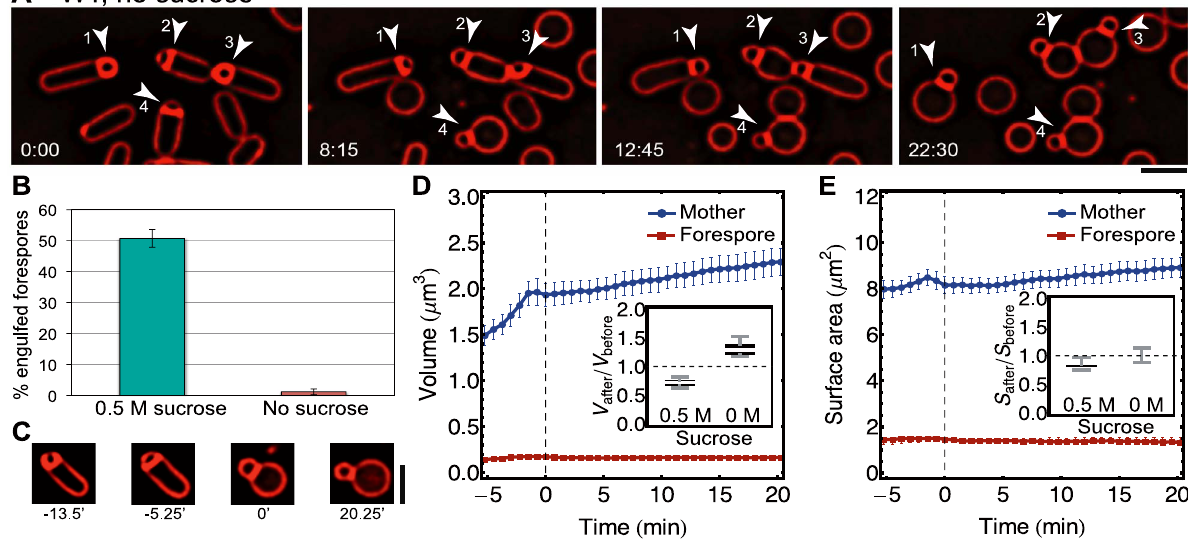
Figure 7. Decreasing medium osmolarity causes retraction as theoretically predicted. (A) Medial focal plane images of sporulating cells treated with lysozyme in osmotically protected medium but without sucrose (see Materials and Methods, Movie S4). Fully engulfed cells retract (cells 1 and 3) while partially engulfed cells (cells 2 and 4) fail to engulf and undergo retraction as well. (B) Percentage of forespore engulfment after lysozyme treatment in medium with 0.5 M sucrose and without sucrose. Average + / 2 STD of four different microscopy fields, each containing 136– 160 cells in sucrose condition and 93–173 cells without sucrose. (C) Images of typical cell undergoing swelling and retraction. Time 0 minutes corresponds to fully rounded mother cell. (D) Mother-cell and forespore volume aligned in time based on 0 time point defined as in (C). After mother cells round, volume steadily increases. (Inset) Volume comparison for experiments with and without sucrose ( p v 10 { 8 ). V after is mother-cell volume * 2 minutes after engulfment or retraction corresponding to 0.5 M surose or no sucrose, respectively. V before is initial mother-cell volume * 8 minutes before transition. (E) Mother-cell and forespore surface area. (Inset) Surface area comparison for cases with and without sucrose ( p v 10 { 5 ). Average + / 2 SEM of n =12 cells in panel (D, E). Scale bars 2 m